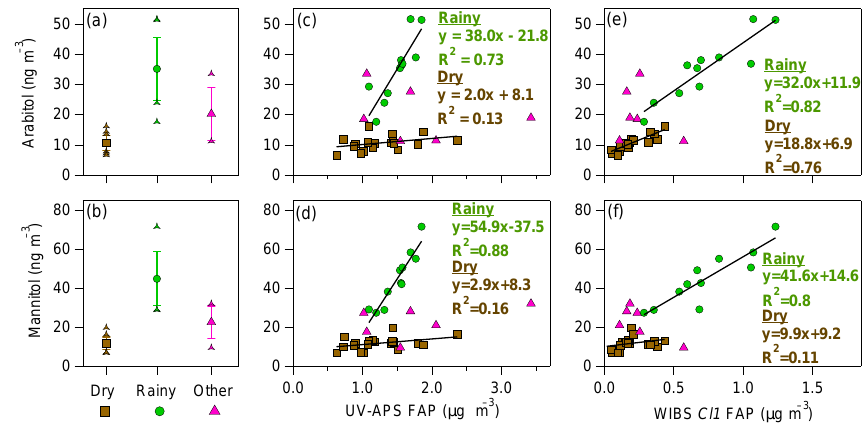
Figure 5. Mass concentrations of molecular tracers and fluorescent particles (calculated assuming unit density particle mass and spherical particles): arabitol – top row and mannitol – bottom row. Average mass concentration of arabitol (a) and mannitol (b) in each wetness category. Central marker shows mean value of individual filter concentration values, bars represent standard deviation (SD) range of filter values, and individual points show outliers beyond mean ± SD. Correlation of arabitol (c) and mannitol (d) with fluorescent particle mass from UV-APS. Correlation of arabitol (e) and mannitol (f) with fluorescent particle mass from WIBS cluster 1. R 2 values shown for each fit in (c–f) . Linear fit parameters are shown in Table